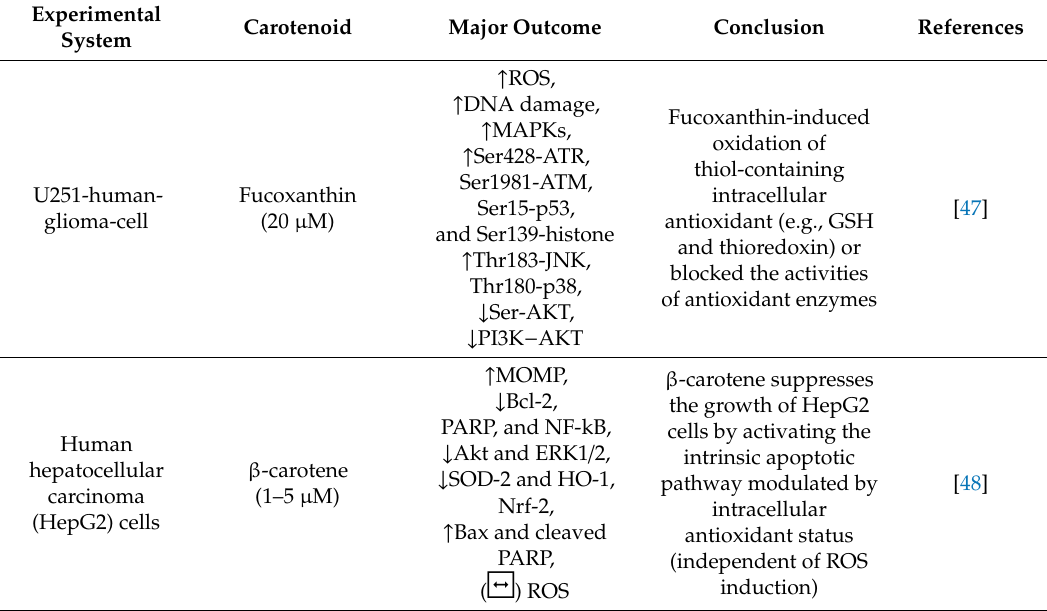
Figure 3. Key pro-apoptotic and anti-apoptotic factors regulated by enhanced reactive oxygen species (ROS) levels, mediated by pro-oxidant effects of carotenoids. Bcl-2: B-cell lymphoma 2; Bak: Bcl-2 homologous antagonist / killer; Bax: Bcl-2-associated X protein; Bcl-xL: Bcl-extra-large; Bim: Bcl-2-like protein 11; NF-kB: Nuclear factor- κ B; PARP: poly (ADP-ribose) polymerase. Table 1. Summary of in vitro mechanistic studies of carotenoids-triggered apoptosis of cancer cells involving pro-oxidant actions of carotenoids.